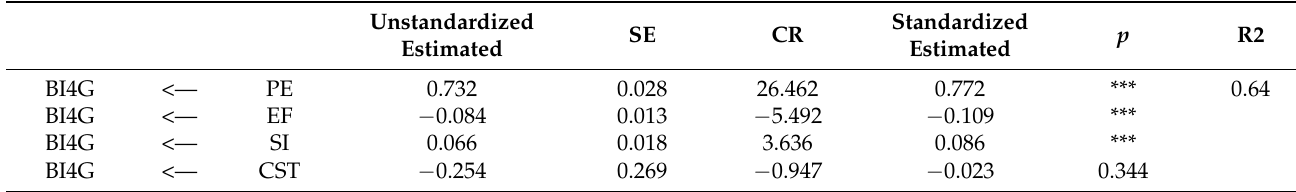
Table 5. Results of hypotheses testing.